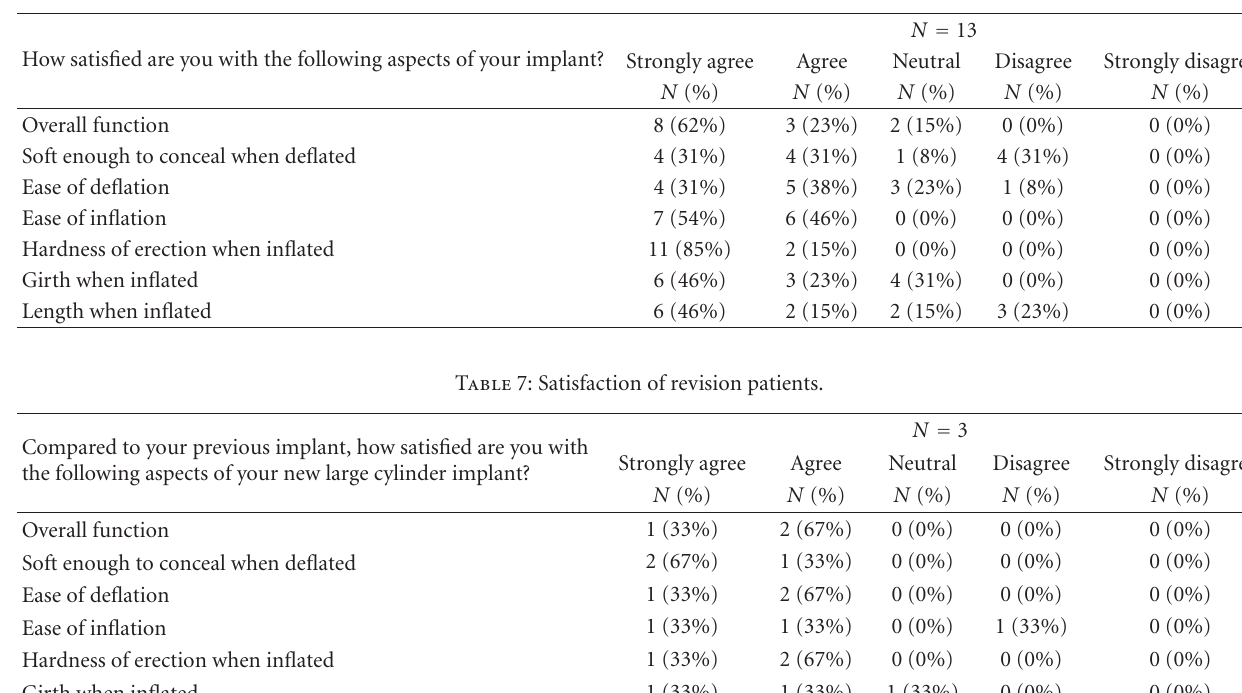
Table 6: Satisfaction of initial implantation patients.